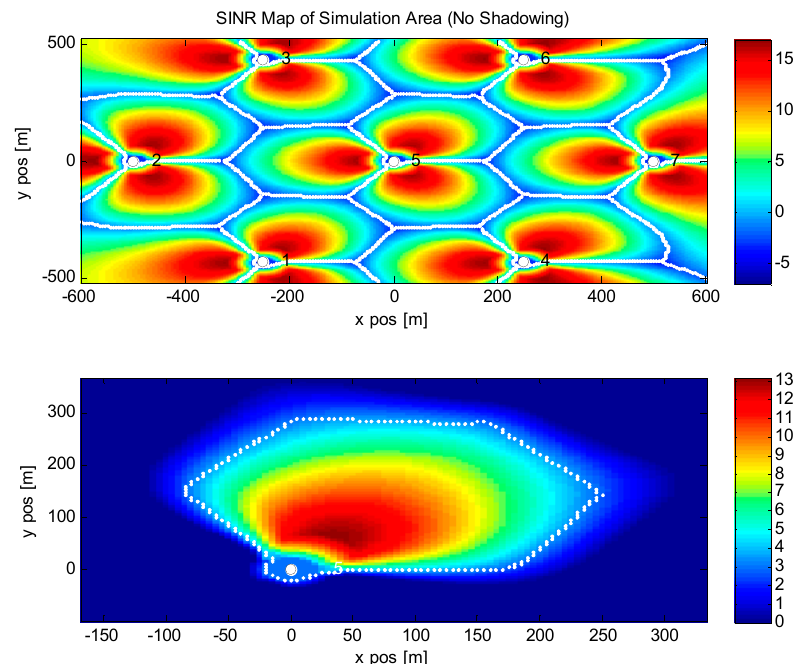
x pos [m] Figure 4. SINR map without shadowing of our simulated area. No shadowing is considered in this figure, so the received SINR is only depending on the distance to the base station from the user. Sectors are quite clear with 120 degree sector angle.